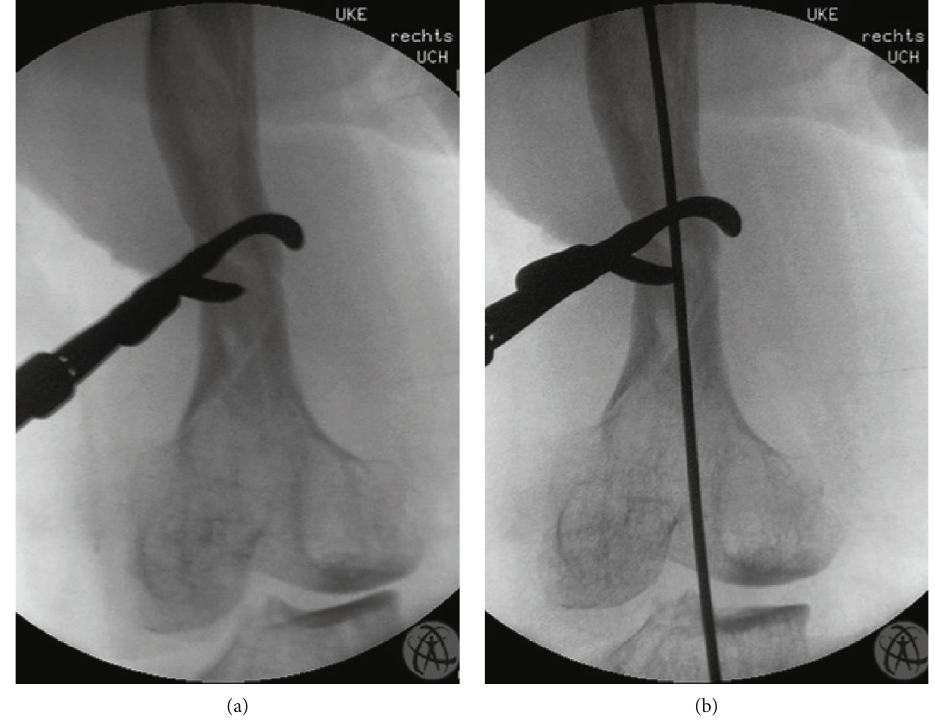
Figure 3: Intraoperative C-arm images. (a) Three major fragments after reduction temporarily fi xated with a sharp reduction clamp. (b) Retrograde implantation of the